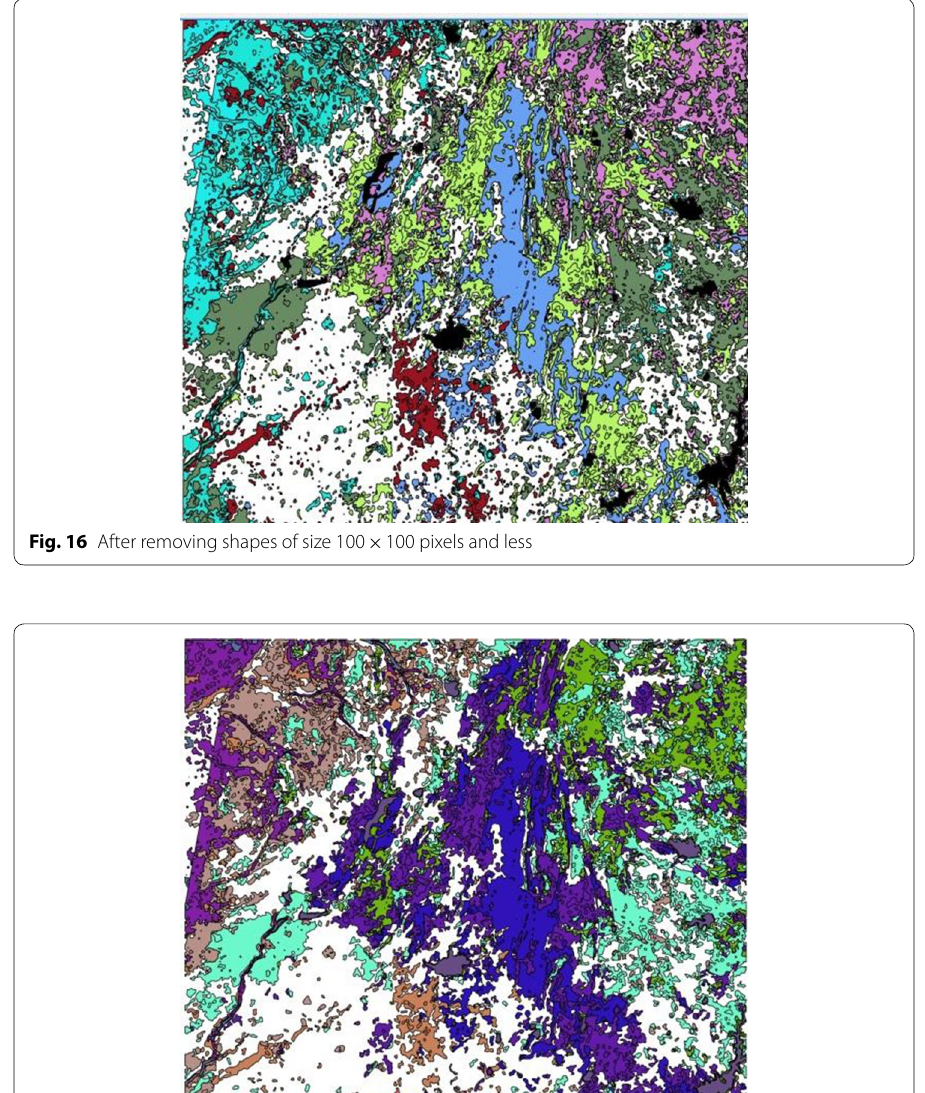
Fig. 17 Removing the smallest 10% of shapes from each